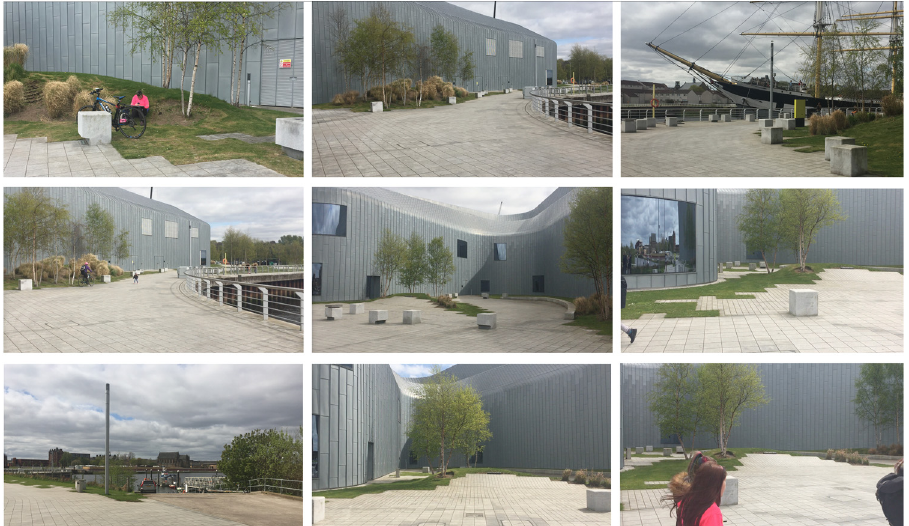
Figure 6. Representation of various attributes of the site and landscape design of the Riverside Museum—collective averaged score of the 11 attributes (3.09 in the 6-point Likert Scale). (Photos by A. Salama)